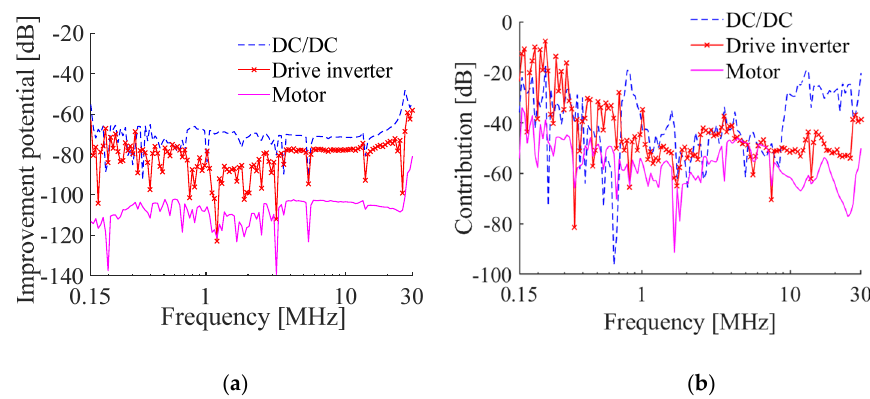
Figure 11. Technical analysis results: ( a ) Improvement potential; ( b ) Contribution.